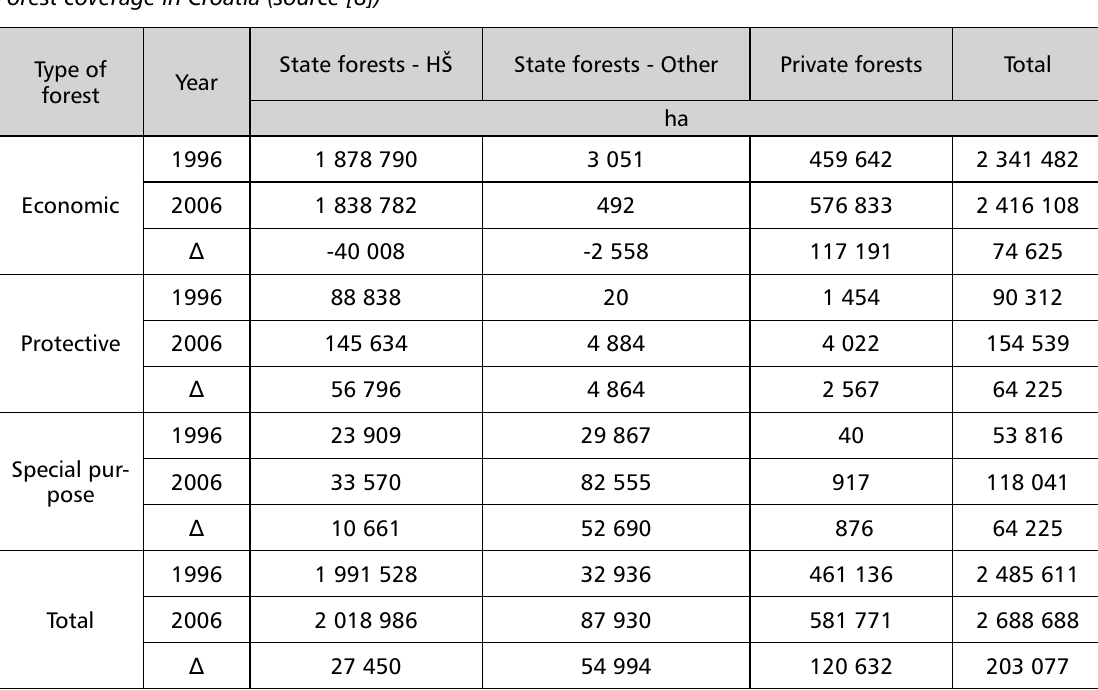
Forest coverage in Croatia (source [8])